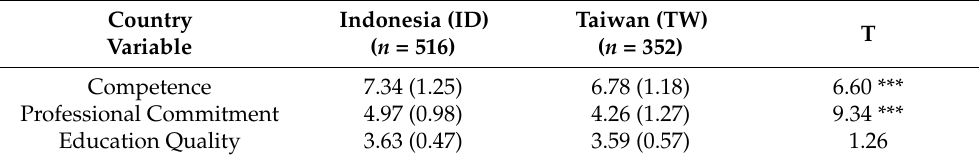
Table 3. Comparison of research variables by country, mean (S.D.), and t -test results. Country